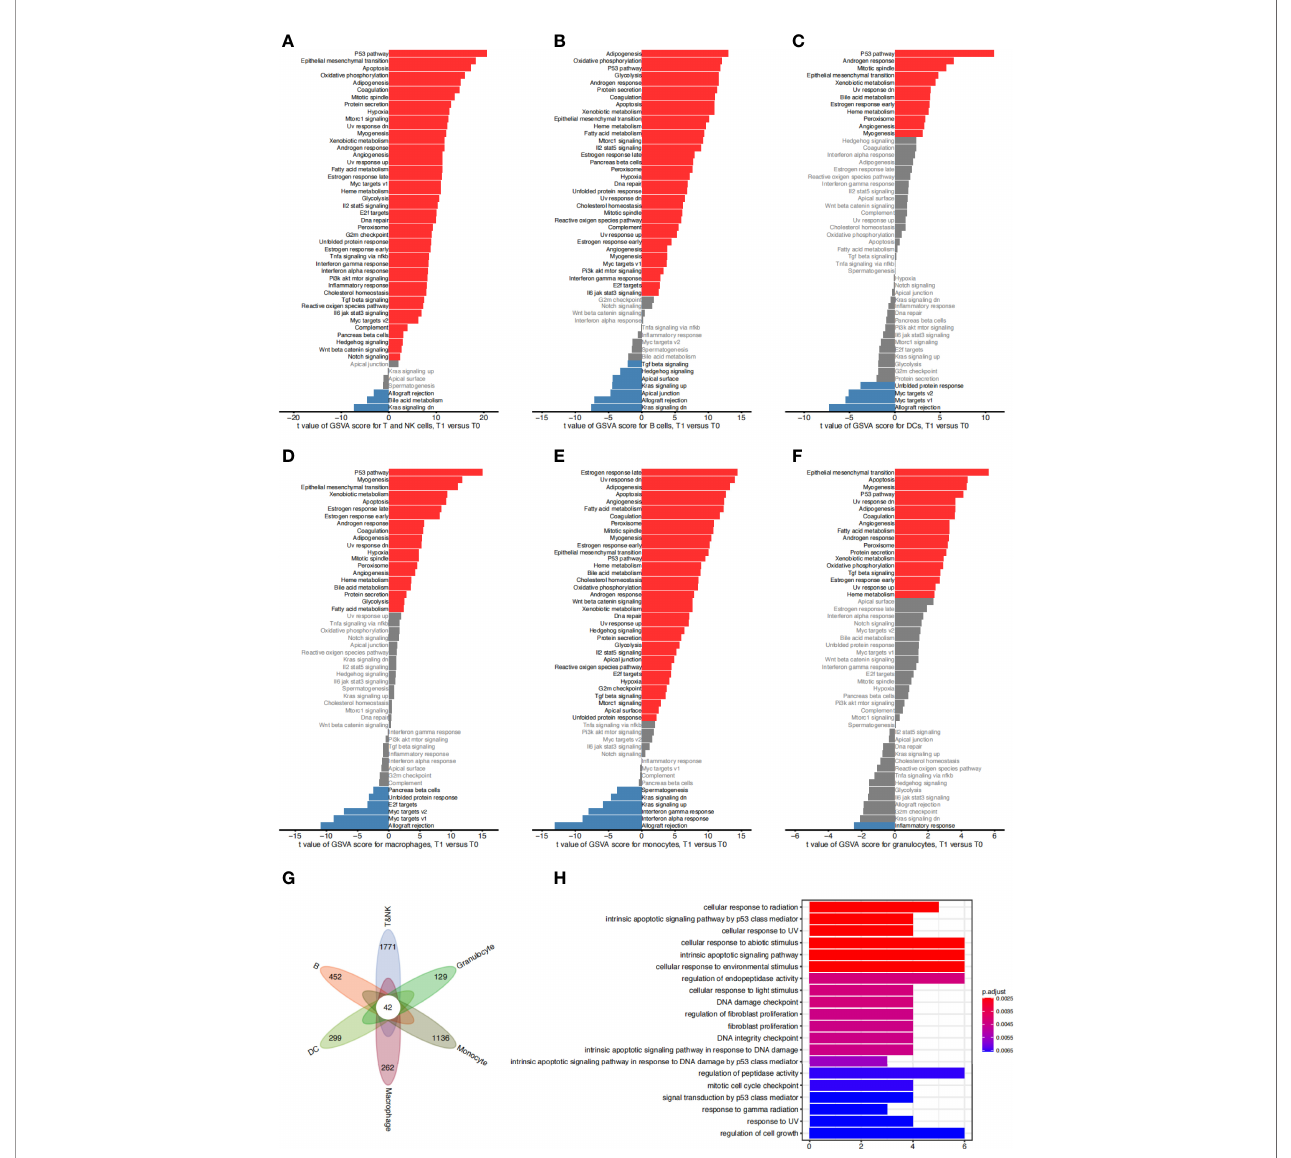
FIGURE 3 | Functional characteristics of sensitive cell types. (A) Difference of hallmark pathway activities between sensitive T&NK clusters (C6, C9, C11, C14) from the control group and 1 day post irradiation. Shown are t values calculated in a linear modal comparing the pathway scores estimated by gene set variation analysis (GSVA) between cells from the two groups. (B – F) The same as (A) for sensitive B clusters (C19, C21) (B) , DC clusters (C18) (C) , macrophage clusters (C5) (D) , monocyte clusters (C10) (E) and granulocyte clusters (C27, C30) (F) . (G) Venn diagram showing the intersection of signi fi cantly upregulated genes of sensitive cells of each cell type from 1 day post irradiation compared to that from the control group. (H) The top 20 signi fi cantly enriched gene ontology (GO) terms of 42 common upregulated genes for sensitive T&NK, B, DC, macrophage, monocyte and granulocyte